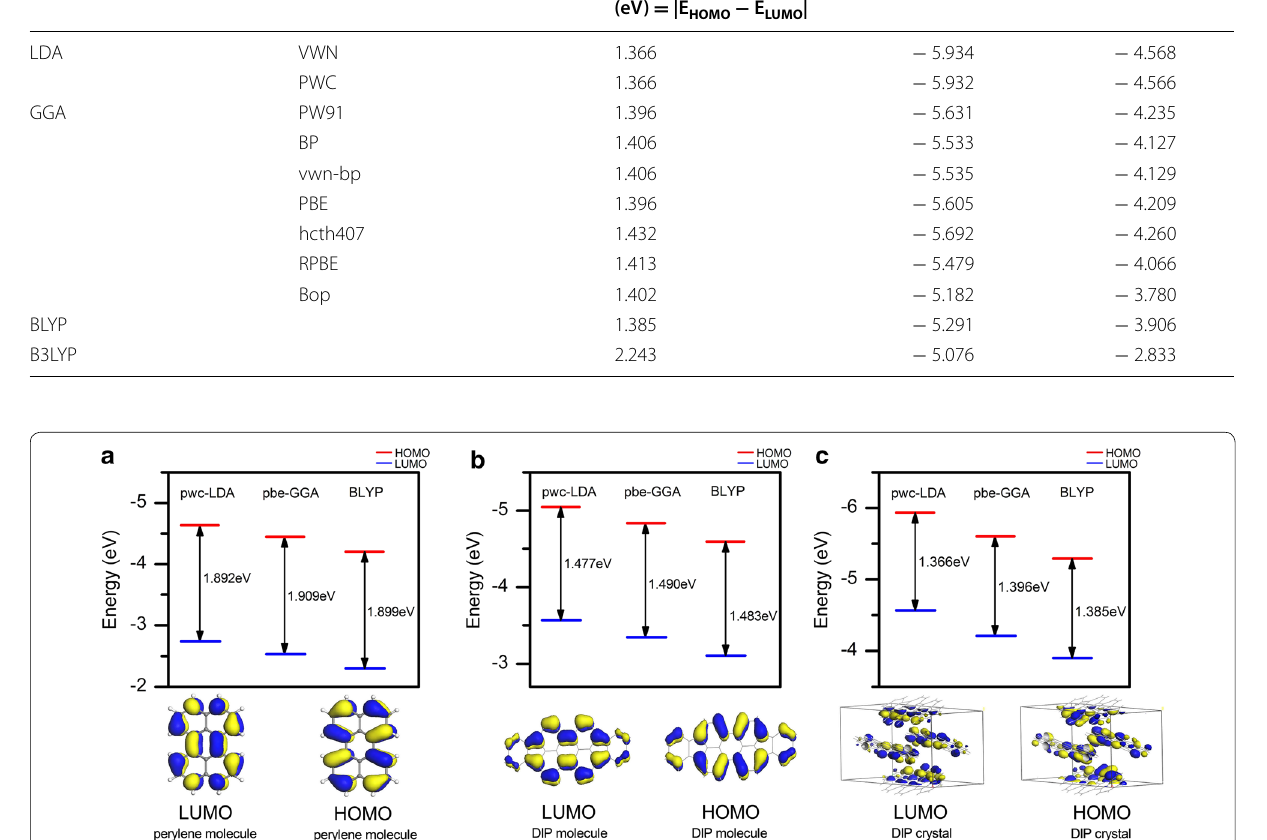
Table 4 The energy gaps of DIP molecular crystal using various E Functional